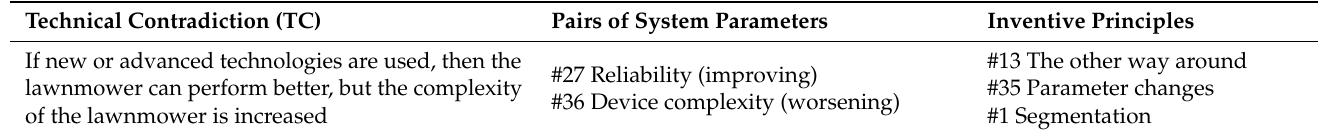
Table 12. Inventive principles from system parameters of technical contradictions (constraint 3).